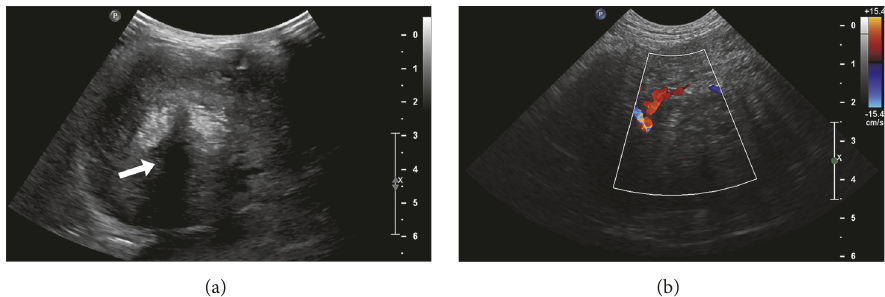
Figure 2: (a) Longitudinal plane sonographic image displaying a well-defined, heterogeneous, non-organ associated abdominal mass with strongly hyperechoic foci within its center, associated with acoustic shadowing (white arrow). (b) Longitudinal plane sonographic image displaying the vascularity of the abdominal mass when interrogated with color